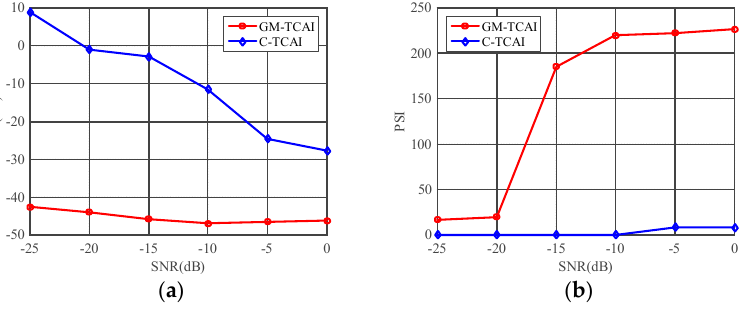
using: ( a ) the relative imaging error (RIE); and ( b ) the probability of successful imaging (PSI),